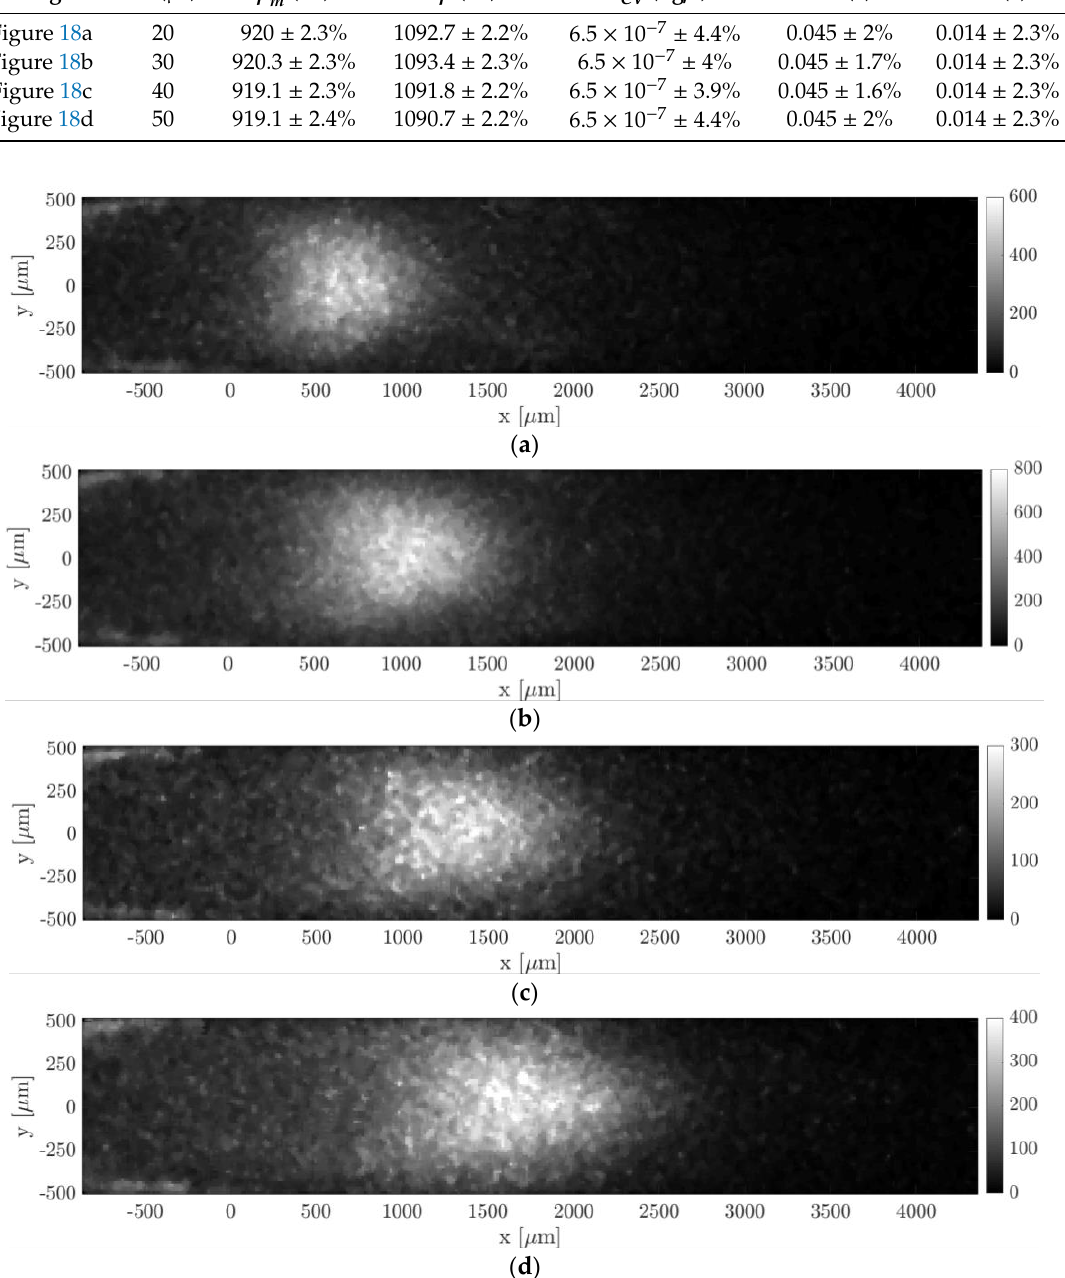
Figure 18. MTV acquisitions of helium–acetone flow with 𝜒 = 20%: ( a ) Δ𝑡 = 20 µs, Δ𝑡 𝑔𝑎𝑡𝑒 = 500 ns, 𝑝 𝑚 = 920 Pa, and Δ𝑝 = 1092.7 Pa; ( b ) Δ𝑡 = 30 µs, Δ𝑡 𝑔𝑎𝑡𝑒 = 1000 ns, 𝑝 𝑚 = 920.3 Pa, and Δ𝑝 = 1093.4 p m = 920 Pa, and ∆ p = 1092.7 Pa; ( b ) ∆ t = 30 µ s, ∆ t gate = 1000 ns, p m = 920.3 Pa, and ∆ p = 1093.4 Pa; Pa; ( c ) Δ𝑡 = 40 µs, Δ𝑡 𝑔𝑎𝑡𝑒 = 500 ns, 𝑝 𝑚 = 919.1 Pa, and Δ𝑝 = 1091.8 Pa; and ( d ) Δ𝑡 = 50 µs, Δ𝑡 𝑔𝑎𝑡𝑒 = ( c ) ∆ t = 40 µ s, ∆ t gate = 500 ns, p m = 919.1 Pa, and ∆ p = 1091.8 Pa; and ( d ) ∆ t = 50 µ s, ∆ t gate = 1000 ns, 1000 ns, 𝑝 𝑚 = 919.1 Pa, and Δ𝑝 = 1090.7 Pa. The recording parameters used are: 𝑁 𝑙 = 100, 𝑁 𝑖 = 20, p m = 919.1 Pa, and ∆ p = 1090.7 Pa. The recording parameters used are: N l = 100, N i = 20, and G = 100%. and 𝐺 = 100%. The acquisitions are made with a 4 × 4 binning. The laser pulse energy was varying between 80 and 100 µJ. 100 µ